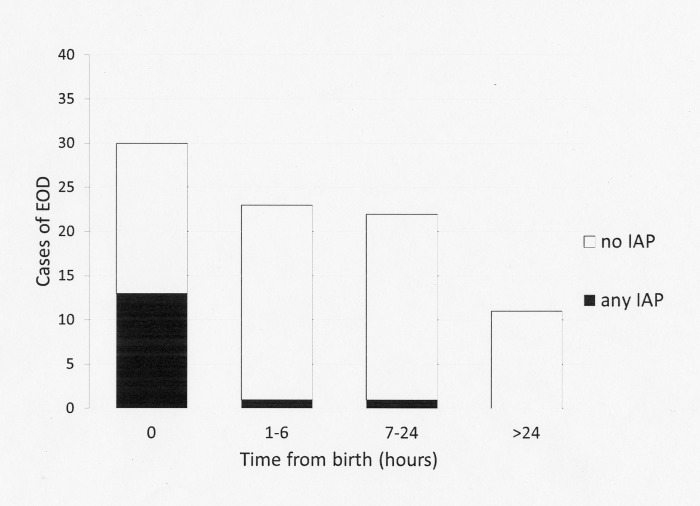
Age of onset of symptoms among IAP-exposed and unexposed neonates (asymptomatic neonates are excluded).IAP, intrapartum antibiotic prophylaxis. Empty bars: cases unexposed to IAP. Black bars: cases exposed to any IAP. Symptoms developed at 0 hours (beta-lactam antibiotics ≥4 hours, n = 4; beta-lactam antibiotics <4 hours, n = 4; non-beta-lactam antibiotics, n = 5). Symptoms developed at 1 to 6 hours (non-beta-lactam antibiotics, n = 1). Symptoms developed at >6 hours (beta-lactam antibiotics ≥4 hours, n = 1).